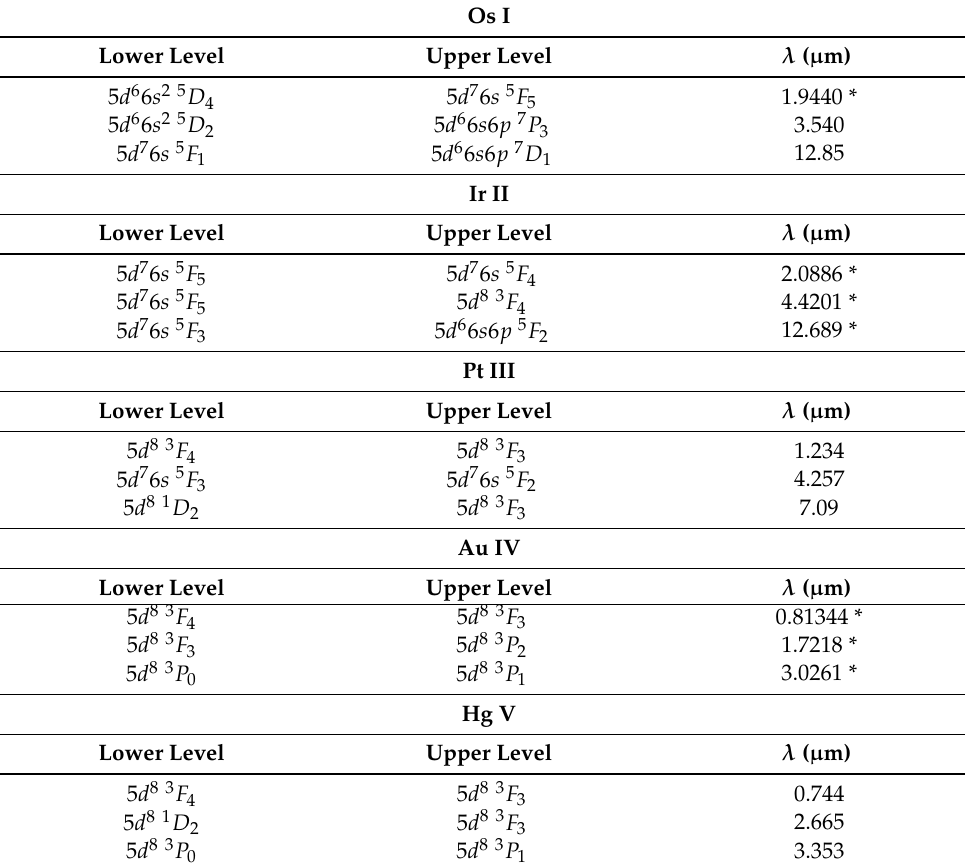
Table 9. Wavelengths of the three most intense IR features at 3700 K from the expansion opacity calculations using GRASP2K data. * Wavelength shifted to experimental